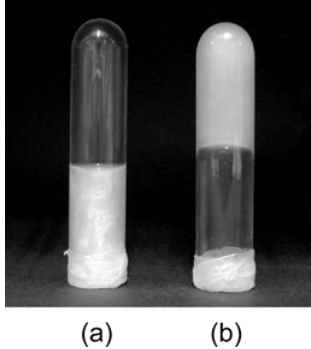
Figure 8. Photograph of a niobate nanosheet colloid (a) before and (b) after gelation induced by addition of H SO [158]. Reprinted with permission from Ref. [158]. Copyright 2 4 2003 American Chemical Society.